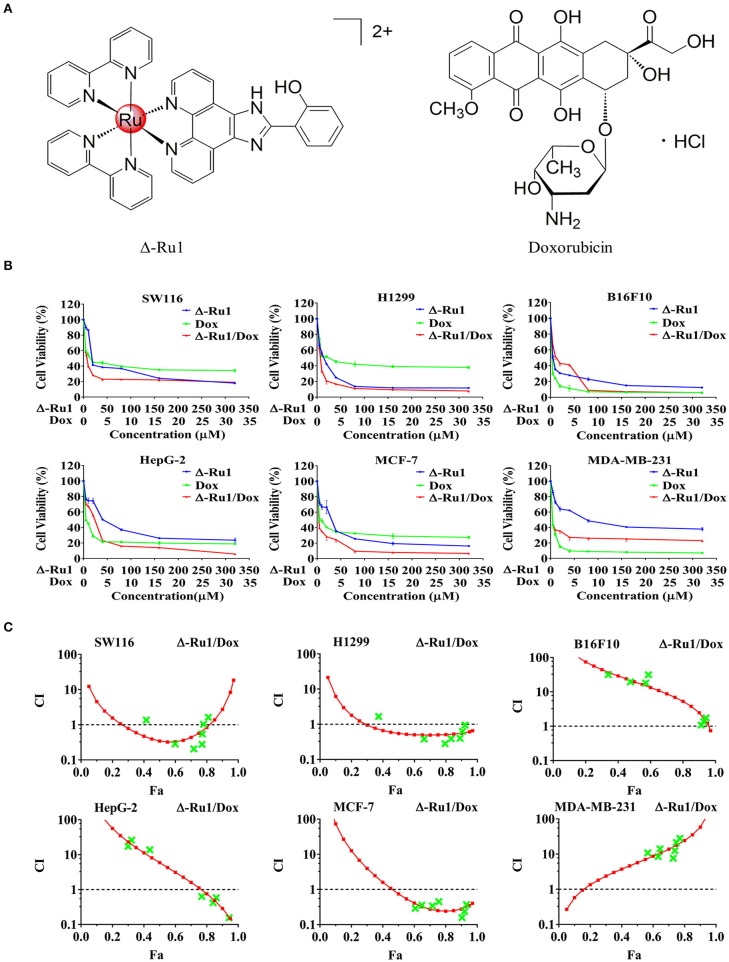
The cytotoxicity of the Δ-Ru1/Dox combination in different cancer cells and the combination index. (A) The chemical structures of Δ-Ru1 and Doxorubicin. (B) Cells viability under the treatment with Δ-Ru1/Dox and determined by MTT assay. Cancer cells (SW116, H1299, B16F10, HepG-2, MCF-7, and MDA-MB-231) were treated with or without Δ-Ru1 (5, 10, 20, 40, 80, 160, 320 μM), Dox (0.5, 1, 2, 4, 8, 16, 32 μM), and the combination of Δ-Ru1/Dox (10:1) for 24 h. (C) Combination index (CI)-fraction affected (Fa, corresponding to the fraction of cell viability) plot of the Δ-Ru1/Dox combination in different cancer cells assessed with Compusyn Software.